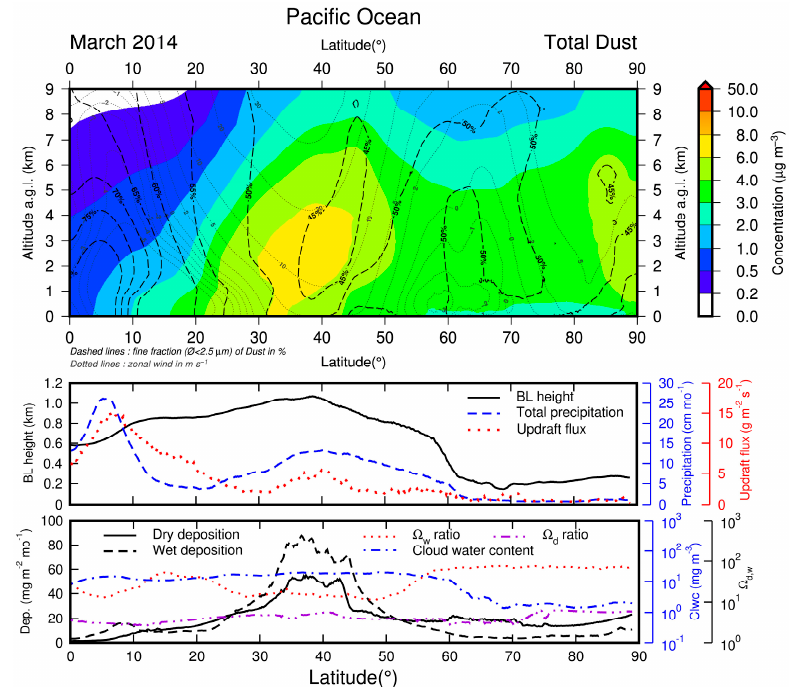
Figure 7. Monthly mean latitudinal cross sections (Altitude a.g.l. versus Latitude ° N) for several variables in March 2014 simulated by CHIMERE for two areas encompassing the Atlantic (80° W–17° W) and the Pacific (122° E–124° W) Ocean areas. Top panels display the mean dust concentrations with bold dashed lines representing the fine fraction of total dust (%), the grey dotted lines are the average zonal winds (conventionally, westerly wind are positive). Bottom charts display the evolution of various parameters along the corresponding cross sections and spatially averaged over the longitude: the boundary layer (BL) height in km, the total precipitation (convective and large scale) in cm month − 1 , the deep convection updraft flux summed over the column in g air m − 2 s − 1 , the mean cloud water content averaged over the first 10 model layers (approximately 2500 m), the wet and dry deposition fluxes of dust sum over time (monthly) in mg dust m − 2 month − 1 and the ratio Ω (unit less) of dry (d) and wet (w) scavenging coefficients coarse versus fine particles as defined in Equation (2).